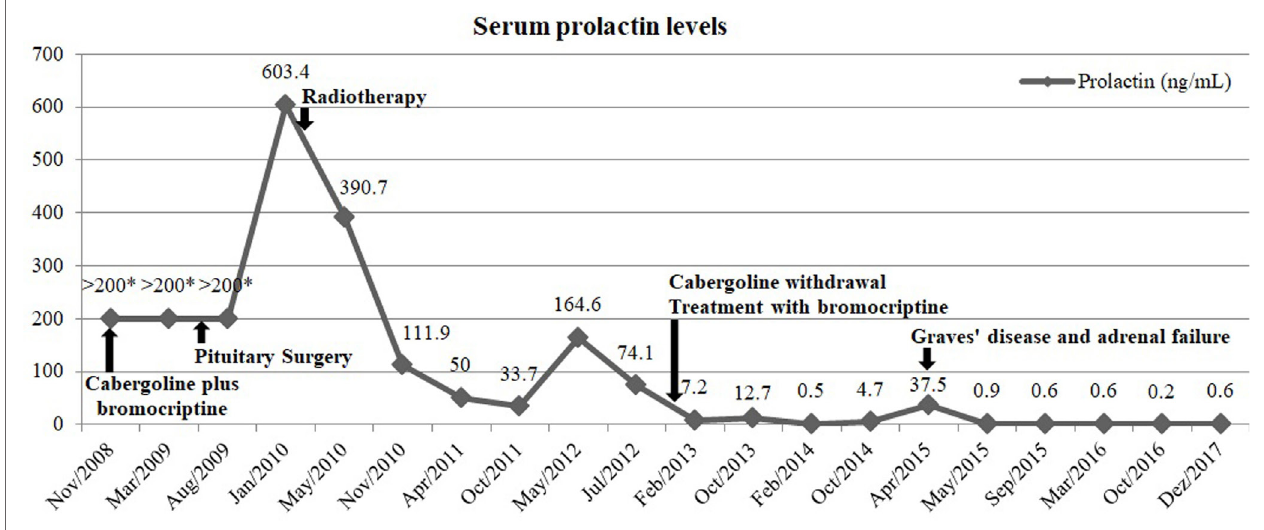
FIGURe 4 | Evolution of serum prolactin levels over time and its relation with medical, surgical, and radiation therapy. *Samples not